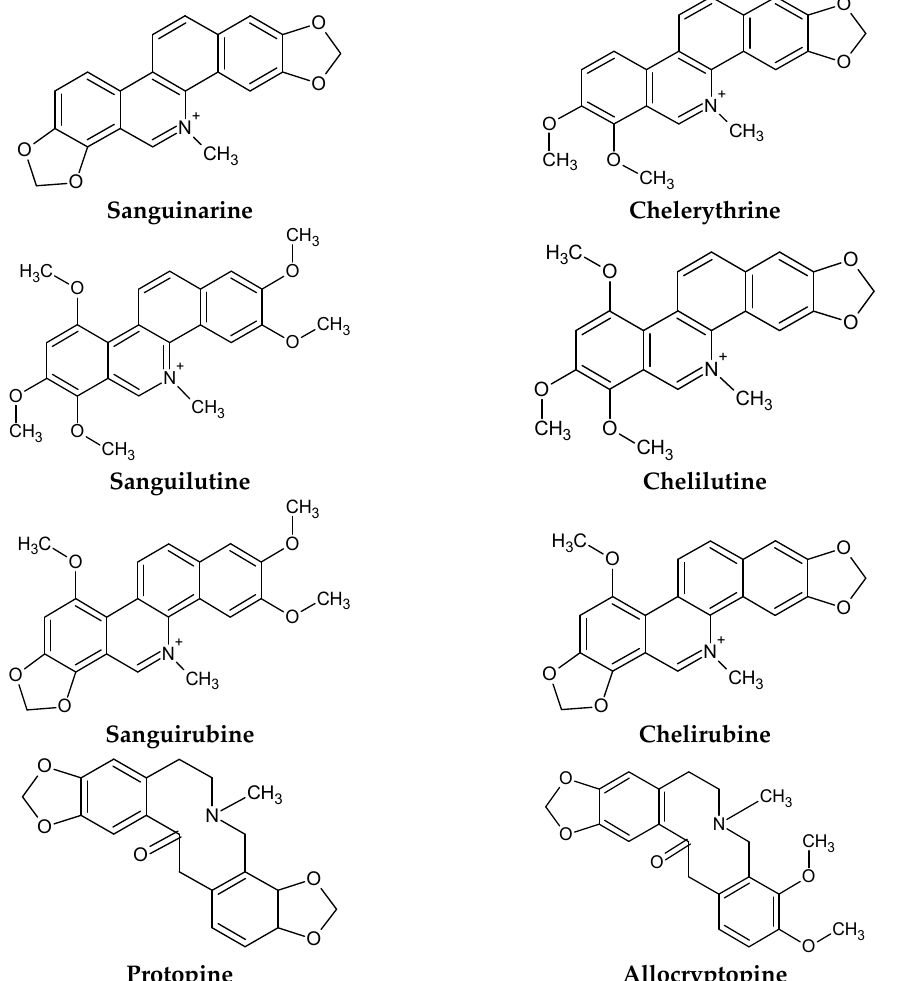
Figure 1. Chemical structures of biologically active S. canadensis alkaloids.